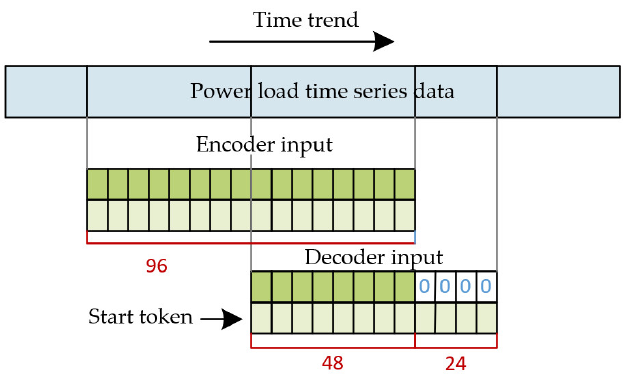
schematic diagram of Start-token in decoder. Figure 4. Calculation diagram of Q